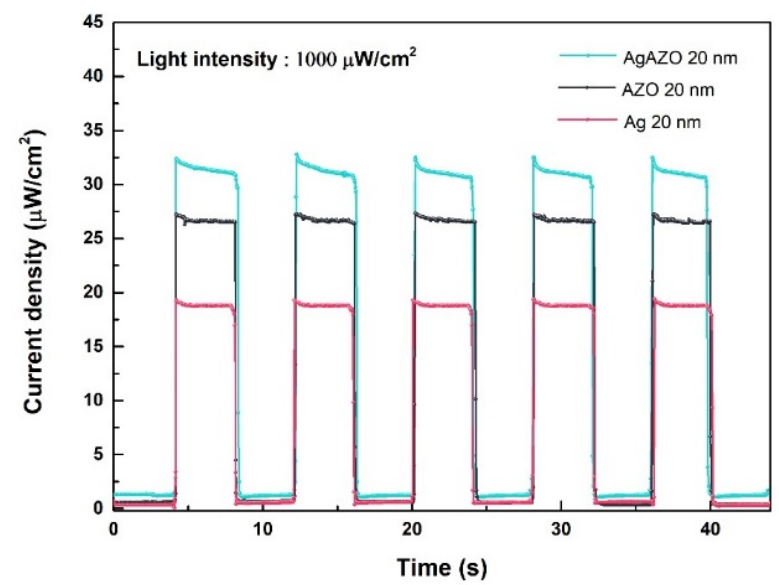
Figure 10. Photocurrent density of each device for 1000 μ W/cm 2 UV light.